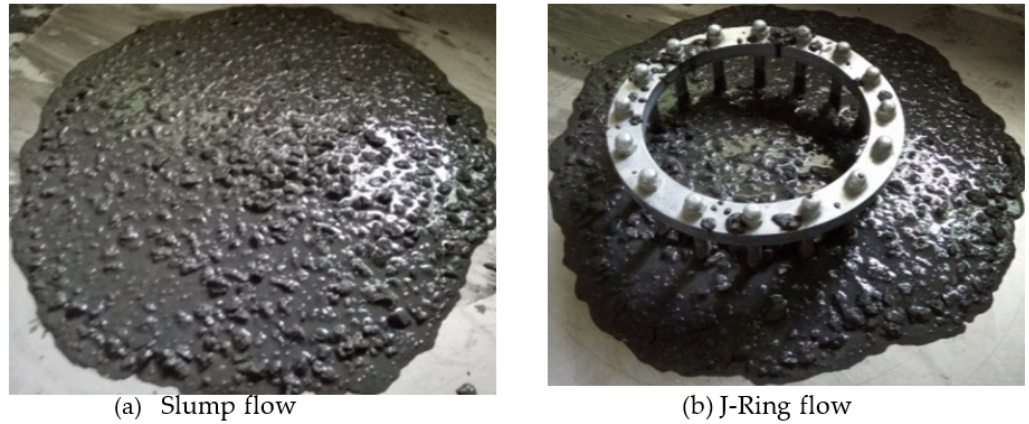
Figure 2. Workability testing.